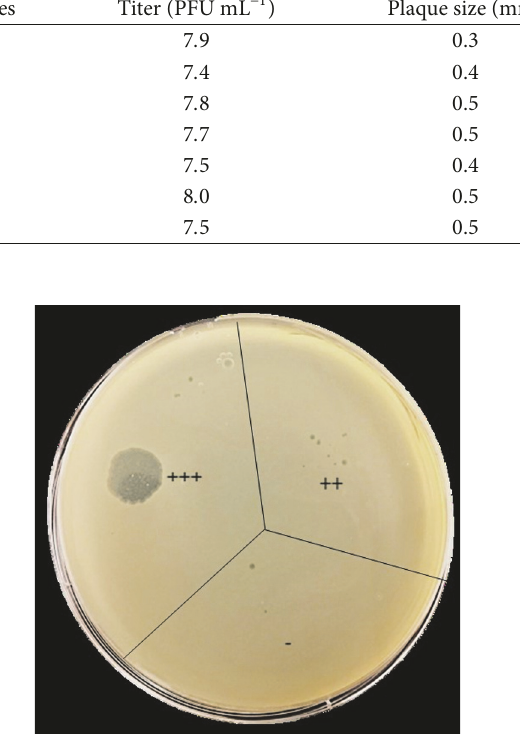
Figure 1: Representative NZCYM agar plate showing the three categories of phage spots: clear (+++), turbid (++), and no reaction (—), on the lawn of host E. coli